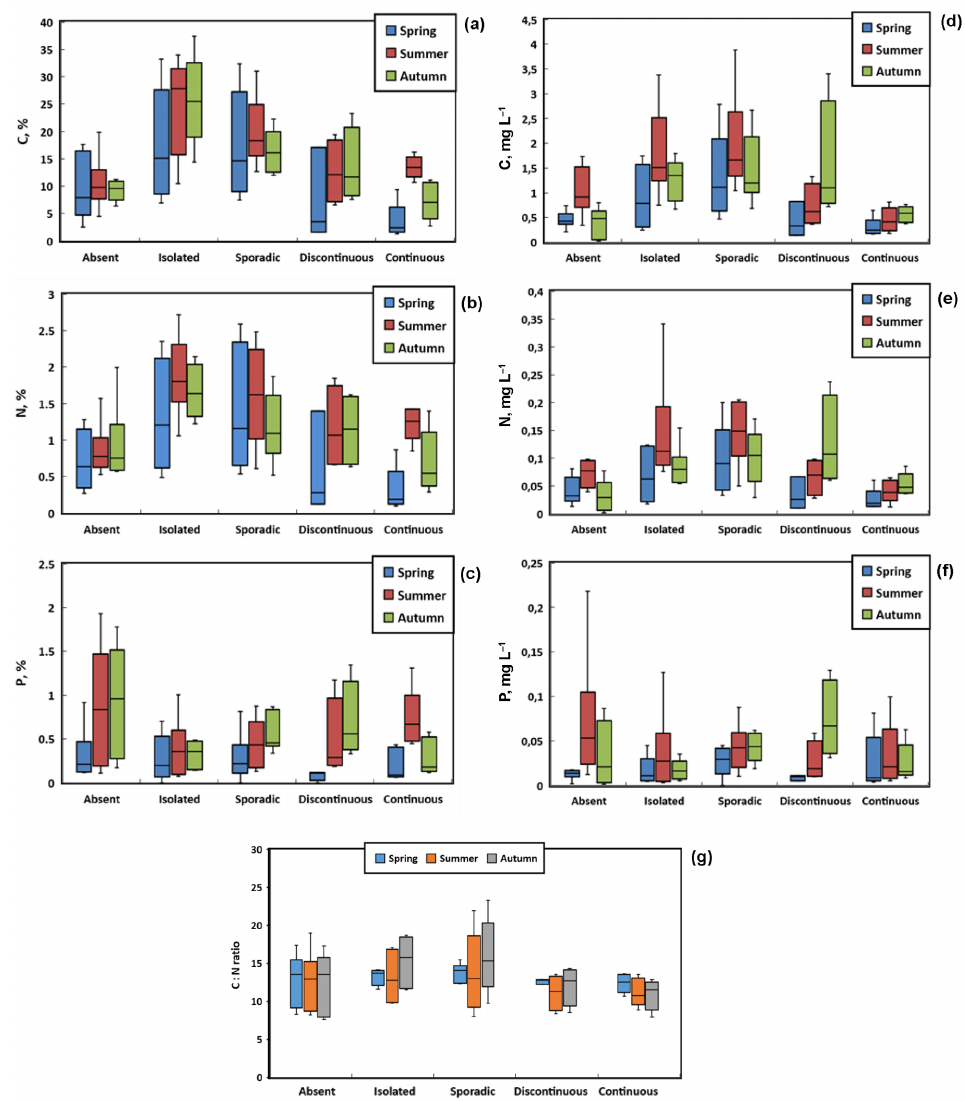
Figure 3. Box plot of first and third quartiles (25% and 75%) of C (a) , N (b) and P (c) concentrations in RSM (%) in five permafrost zones over three seasons. The C, N and P concentrations in the river water are shown in panels (d) , (e) and (f) , respectively, and a C : N ratio is shown in (g)